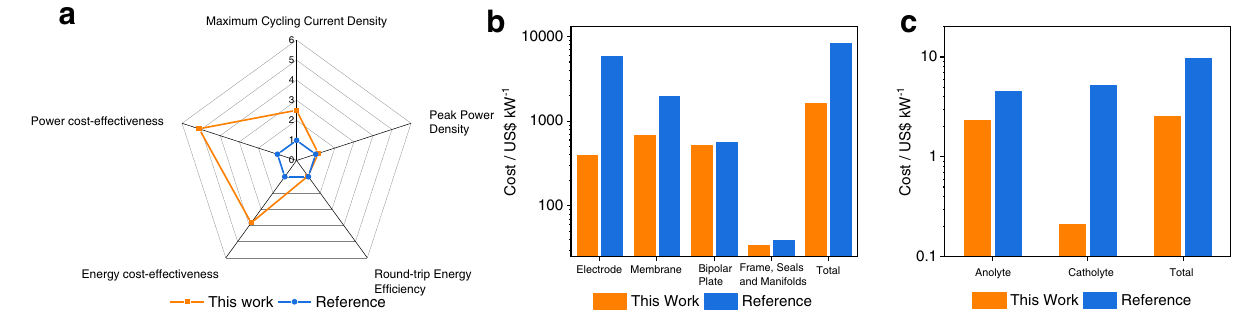
Fig. 6 Comparison of the performance and costs of polysul fi de/air RFBs. a Key performance indicators (power cost-effectiveness and energy cost- effectiveness refers to the reciprocal of power cost and energy cost, respectively). b Costs of major components and the total stack cost. c Costs of anolyte and catholyte and total electrolyte cost. Reference refers to data reported in ref. 24